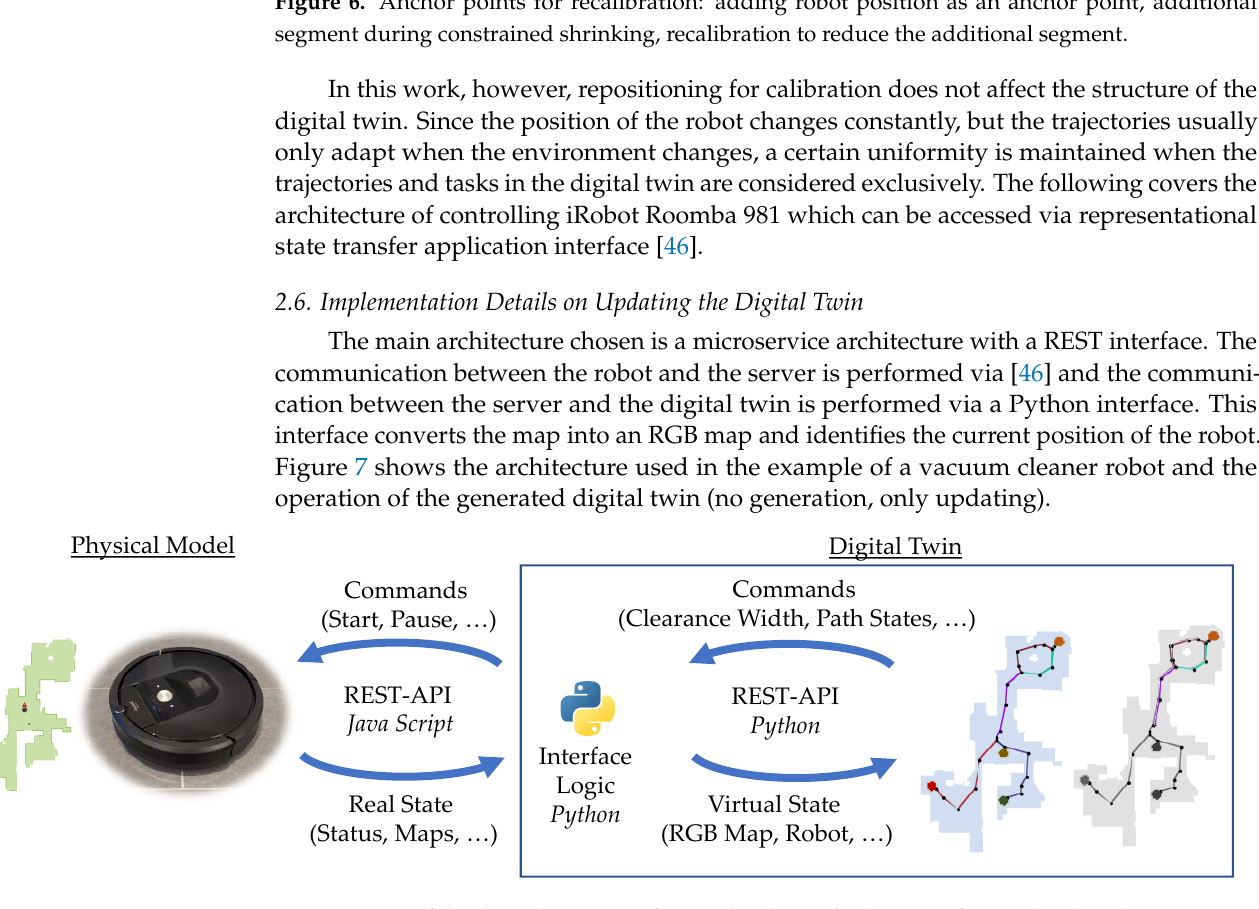
Figure 7. Use of the digital twin: interface to the physical robot, interface to the digital twin.